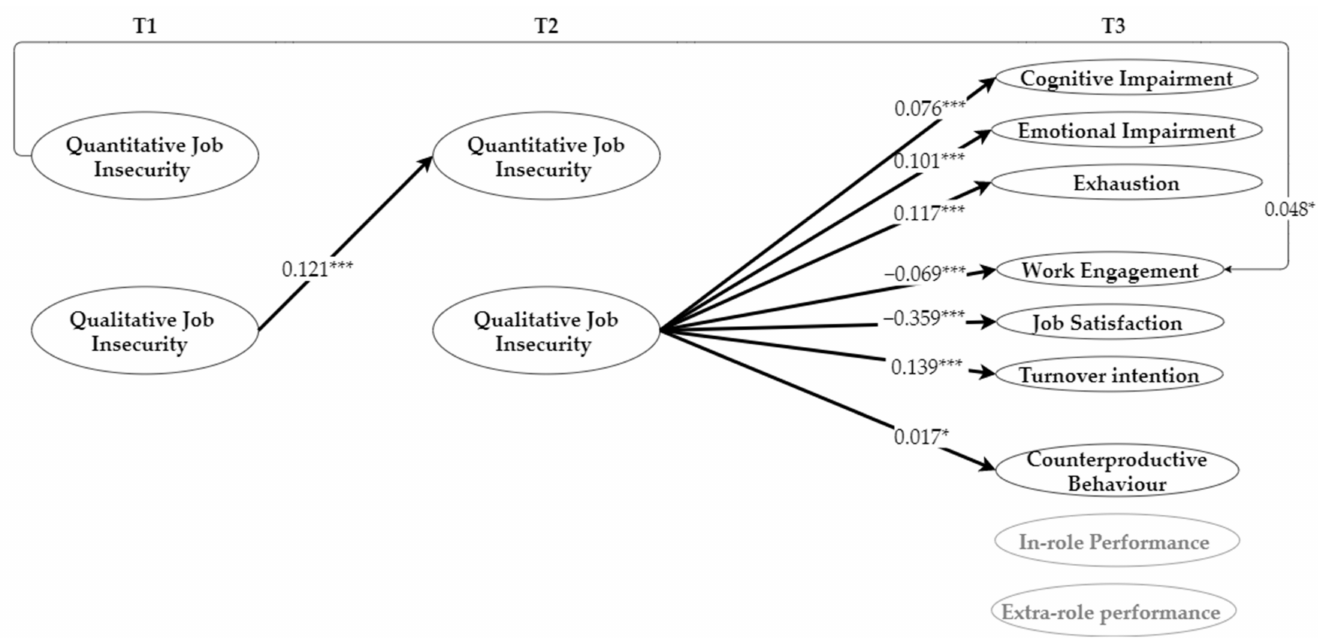
Figure 2. Autoregressive cross-lagged panel model with unstandardized path coefficients. Note: p < 0.05 *, p < 0.01 **, p < 0.001 ***; T1/T2/T3 indicate measurement waves; control variables as well as autoregressive and insignificant pathways are omitted for